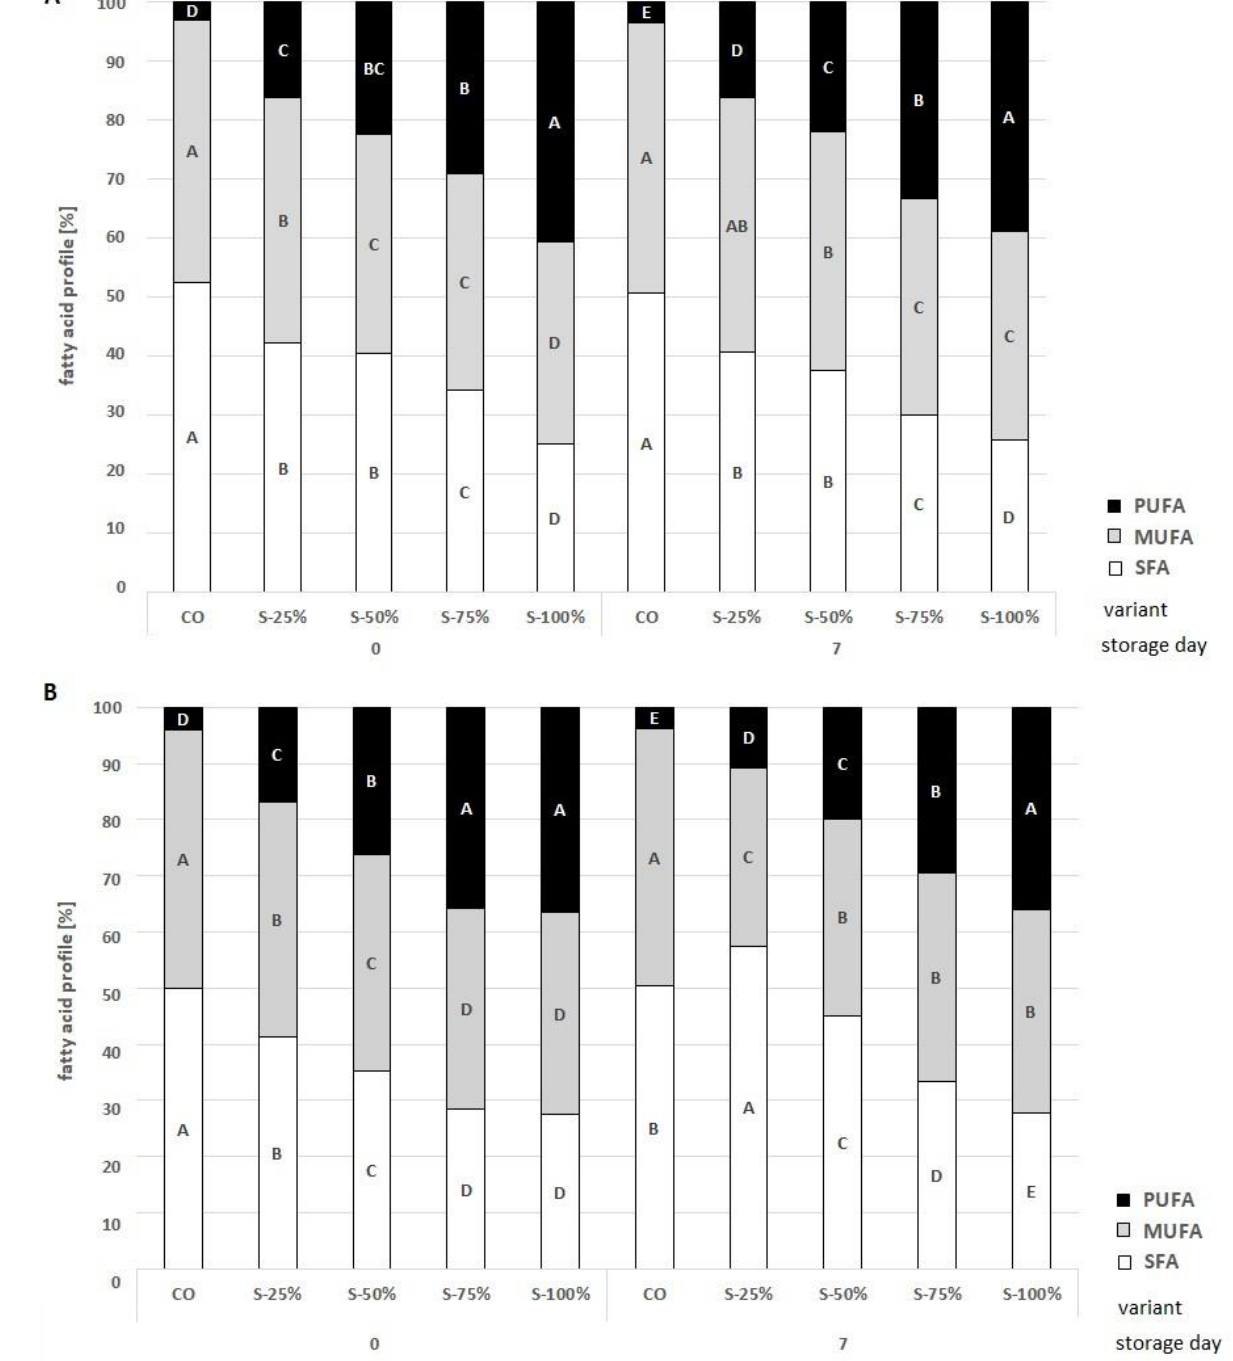
Figure 6. Effects of a fat substitute (freeze-dried hydrogel emulsion with encapsulated açai oil) on the fatty acid profile of raw ( A ) and grilled ( B ) burgers at 0 and 7 days of storage in cold conditions; CO-control with tallow (0% fat substitute), S-25%, S-50%, S-75%, S-100% means respectively replacing beef fat with 25, 50, 75, and 100% substitute. A–E —means with different letters showing a significant effect of the treatment group in the same day of storage, p < 0.05.